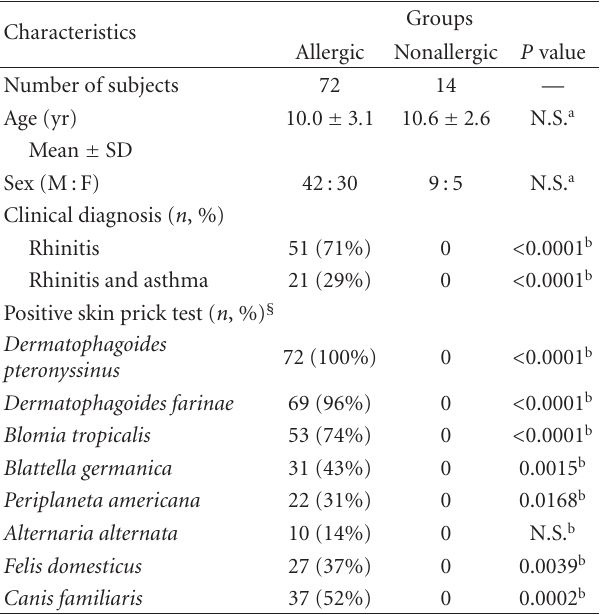
Table 1: Demographic and clinical characteristics of the study